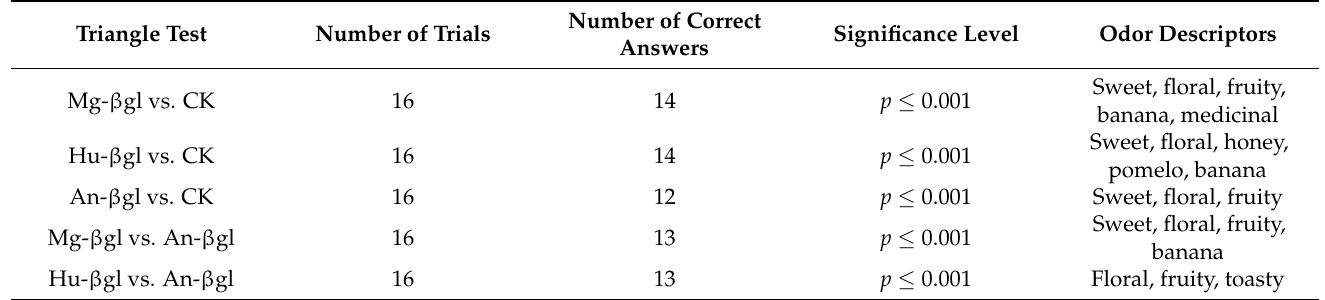
Table 3. Sensory analysis of Chardonnay wine treated with purified enzymes (Mg- β gl and Hu- β gl) and commercial enzyme (An- β